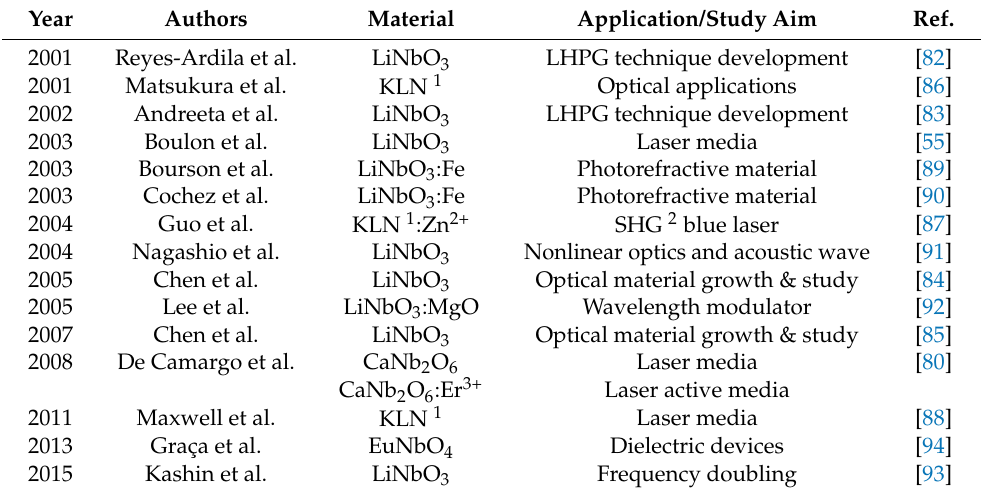
Table 2. Niobates grown by LFZ since the review by Rudolph and Fukuda in 1999 [8]